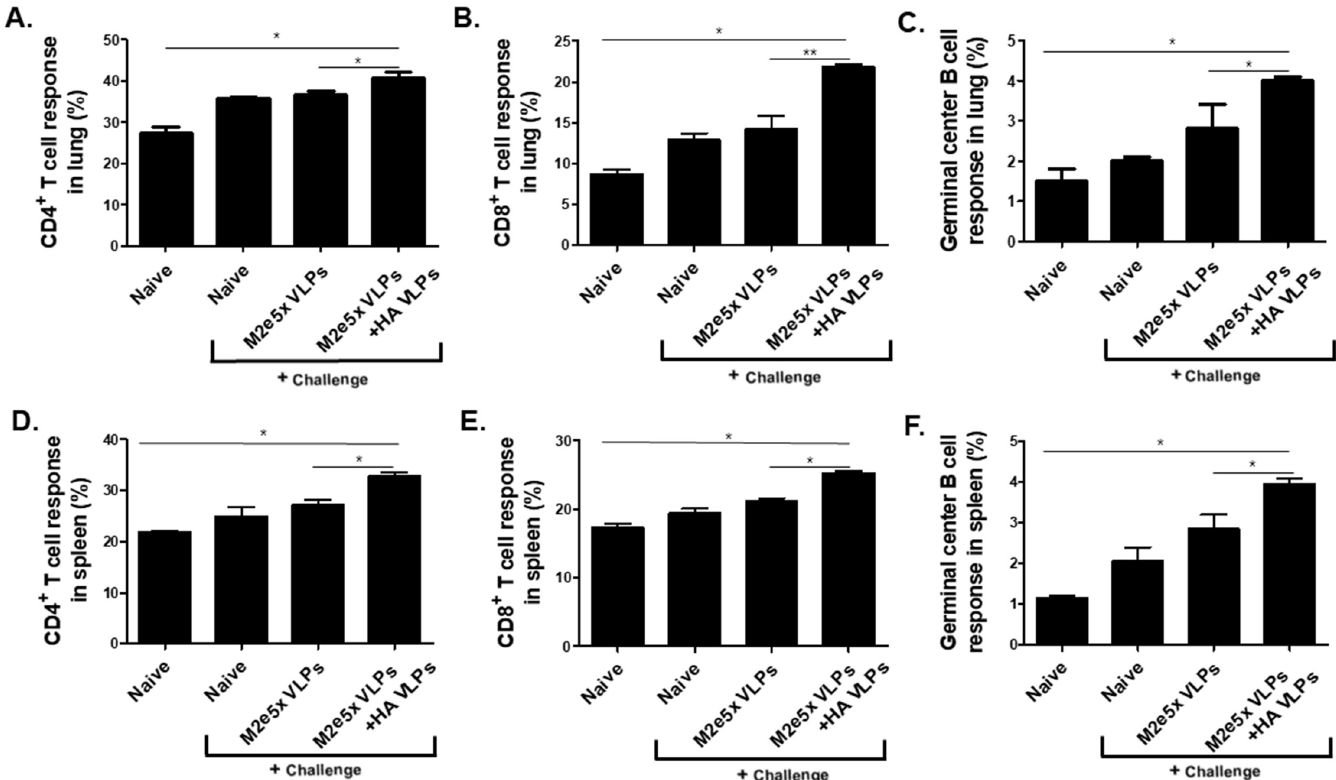
Fig 5. Combinatorial VLPs vaccine induces high levels of CD4 + , CD8 + T cell and germinal center B cell responses after challenge infection. CD4 + T cells (A and D), CD8 + T cells (B and E) and germinal center (GC) B cell (C and F) in lung and spleen were analyzed by flow cytometry at 4 days after challenge with A/Viet Nam/ 1203/2004 (rgH5N1) virus. Percentages of cell populations in each. Higher populations of CD4 + , CD8 + , and GC B cell were detected in combinatorial VLPs group compared to M2e5x VLPs or Na ï ve + Challenge group ( � P < 0.05). Data are expressed as mean ± SD.